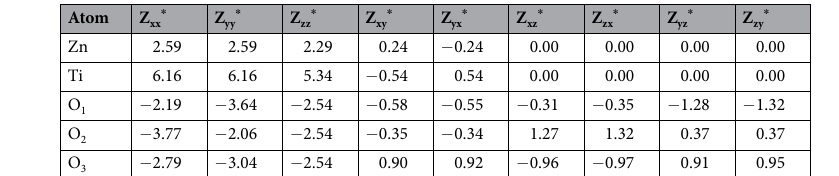
Table 2. The calculate Born effective charge of Zn, Ti, O 1 ∼ 3 in LN-type ZnTiO 3